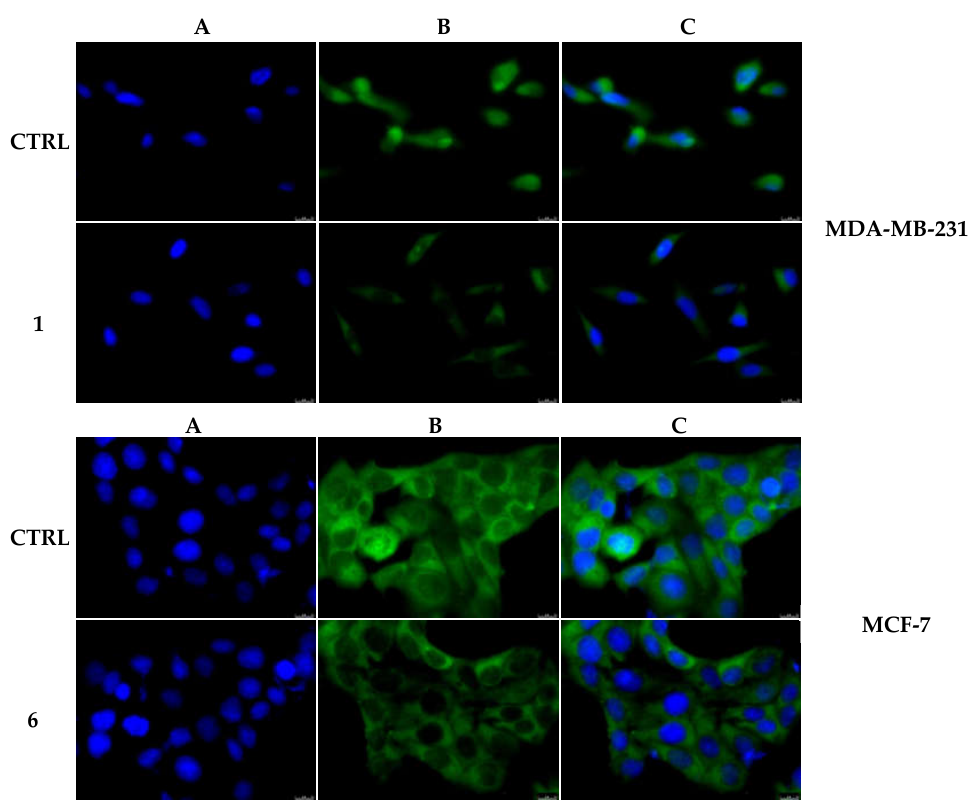
Figure 13. NF-κB activation in MDA-MB-231 and MCF-7 cells after treatment with compounds 1 and 6 , respectively. In the vehicle-treated cells, NF-κB is localized within the cytoplasm and nucleus, while the treatment of the breast cancer cells with compounds 1 and 6 for 24 h (used at their IC 50 values) reduced the NF-κB presence in the nucleus. Panels A, nuclear stain with DAPI (λ ex/em = 350/460 nm); Panels B, Alexa Fluor CF 488 (λ ex/em = 490/515 nm); Panels C, overlay channels. Images were acquired at 40× magnification and representative fields are shown.